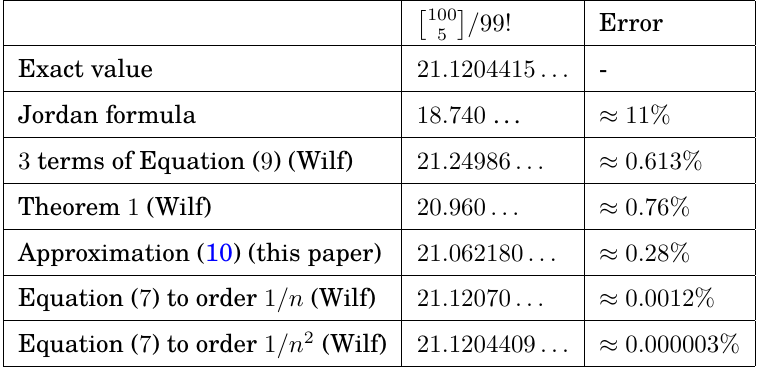
Table 2: Several approximations of the maximal value for n = 100 (see Wilf [35], page 349 for details). We have µ 100 (1) ≈ 5 . 19 and σ 100 (1) ≈ 1 . 88477 . Wilf considers the value of